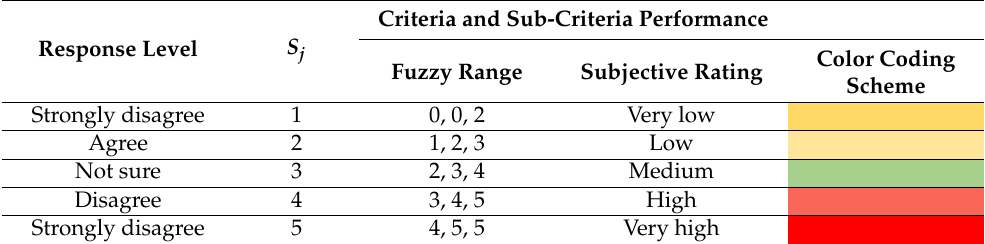
Table 2. Subjective response levels and street-lighting system effectiveness